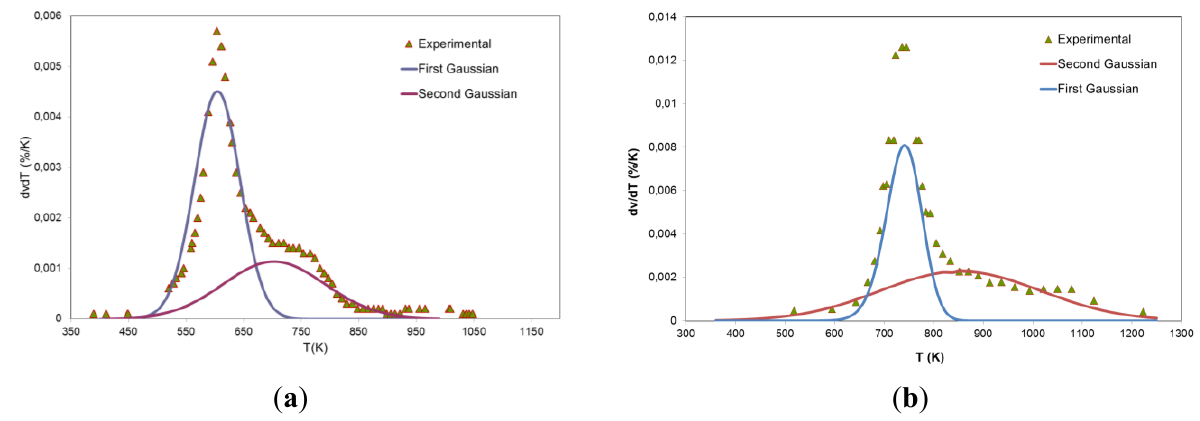
Figure 10. Comparison between experimental reaction rates and reaction rates obtained with the 2-DAEM kinetic parameters at a heating rate of 100 K·min −1 . ( a ) Biomass and ( b ) Sulcis coal.